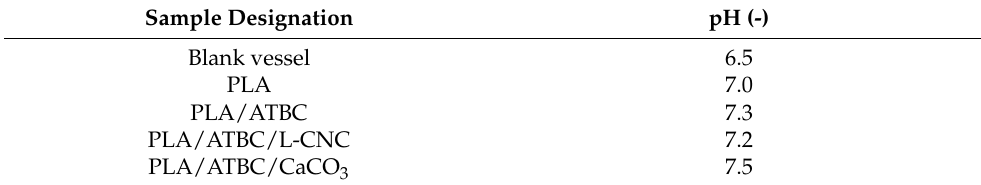
Figure 1. Biodegradation curves of PLA biocomposites under controlled composting ISO 18455-1. Table 3. Evaluated pH of compost at the end of the experiment.